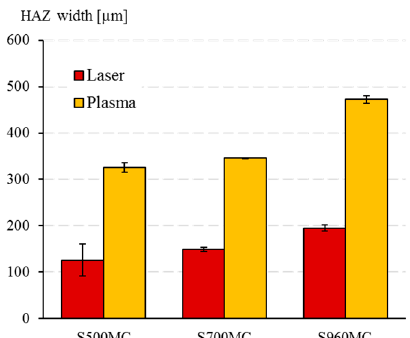
Figure 7. Average HAZ width in laser- and plasma-cut holes for S500MC, S700MC, and S960MC.